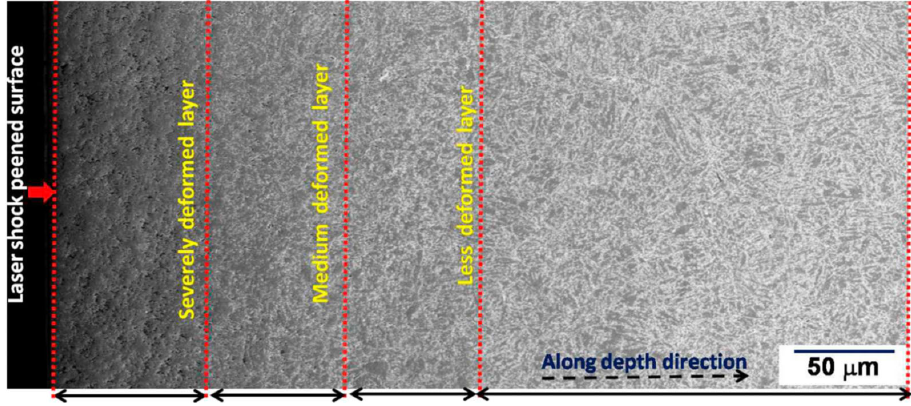
Figure 5. The microstructure change can be viewed as different zones along the direction [81].